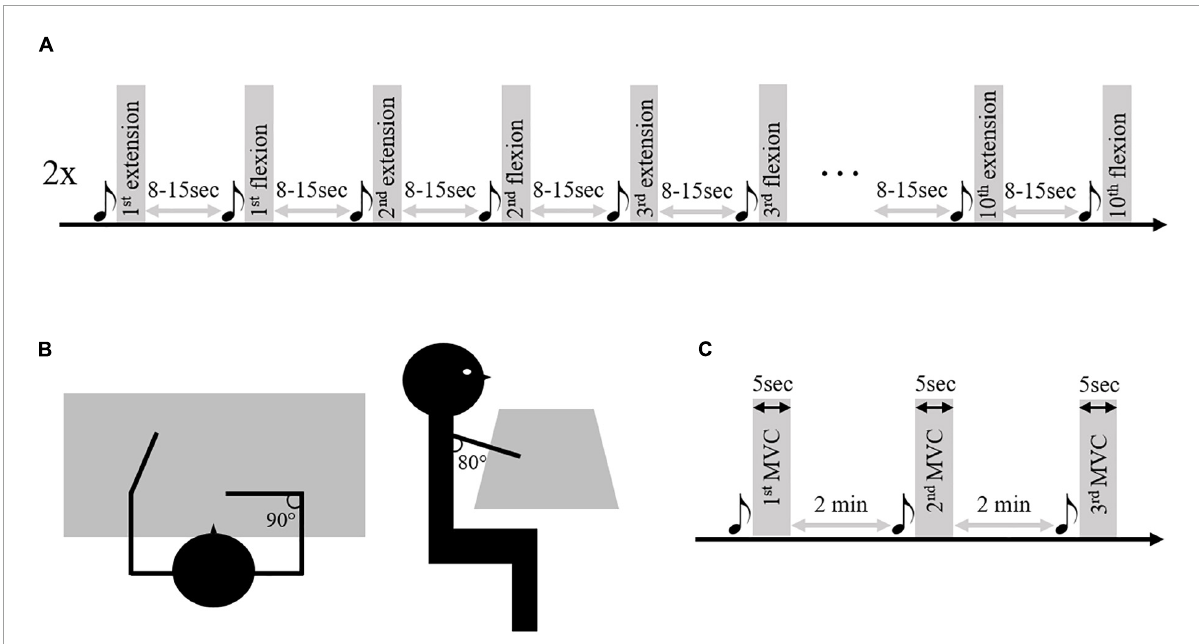
FIGURE1 Illustration of the research protocol. Panel (A) represents the two series of 10 elbow extension/flexion movements performed by the patients and control subjects. Panel (B) represents the starting position. Panel (C) represents the maximal voluntary contraction (MVC) series performed on the isokinetic ergometer. The musical notes represent the sound signal indicating the beginning of the movement.